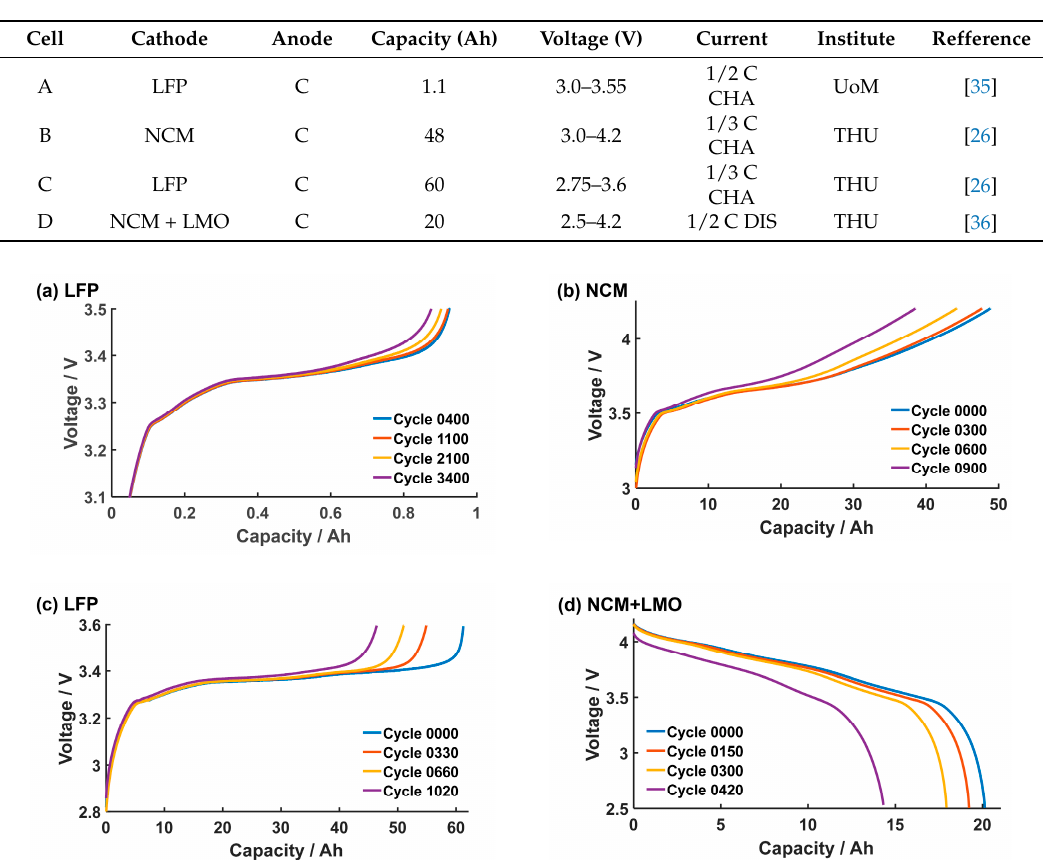
Table 1. Degradation tests of commercial lithium-ion batteries for validating the methodologies. The